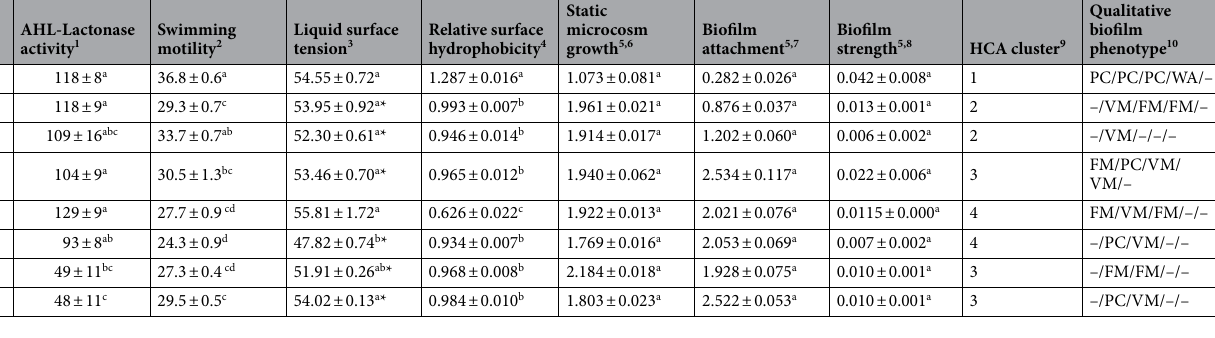
Table 1. Characterisation of Bacilli strain colonisation-associated behaviours. 1, AHL Lactonase activity measured as mm 2 inhibition/24 h. 2, Swimming measured as mm/24 h. 3, Liquid surface tension determined for static KB cultures as mN/m after 3 days incubation (the liquid surface tension of sterile KB was 57.62 ± 0.09 mN/m). 4, Measured by relative differences in OD 600 . 5, From combined biofilm assays using KB microcosms. 6, Growth measured as final population size, OD 600 . 7, Biofilm attachment to the vial walls measured using Crystal violet, A 570 . 8, Biofilm strength measure using glass balls, g. 9, From the HCA Constellation plot shown in Fig. 2. 10, Biofilm-formation was tested in LB, KB, BHI, NB and M9-Gluc microcosms (left to right) and categorised as FM (Floccular Mass) PC (Physically Cohesive), VM (Viscous Mass) or WA (Waxy Aggregate) class biofilms (–, no biofilm observed). Means and SE are shown; means with same superscript letter are not significantly different (within assays, TK-HSD, α = 0.05). *, Significantly different from sterile medium control (Dunnett’s, p < 0.05).